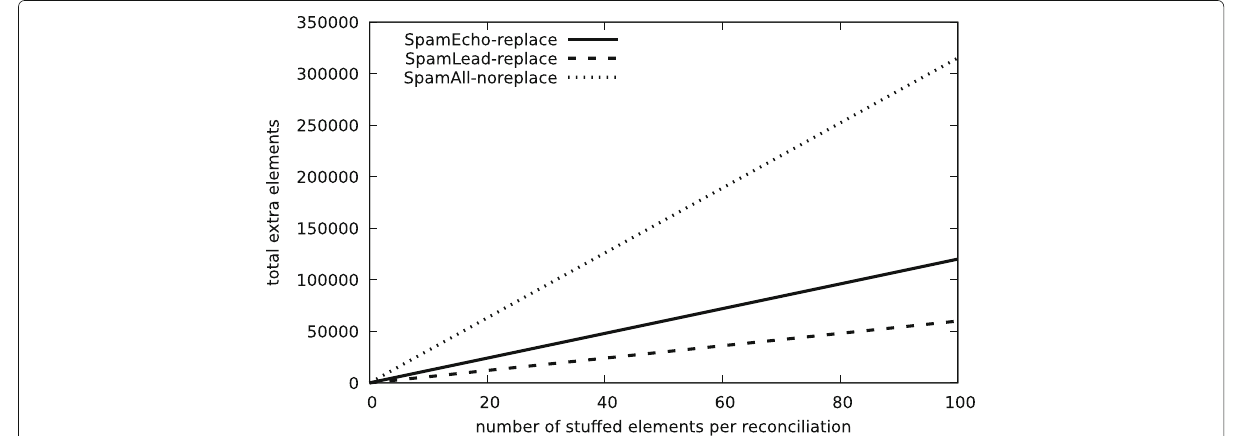
Fig. 11 Total number of extra elements received by each peer for BSC on 100 elements of 64 bytes and one malicious peer with the indicated mode. Average over 50